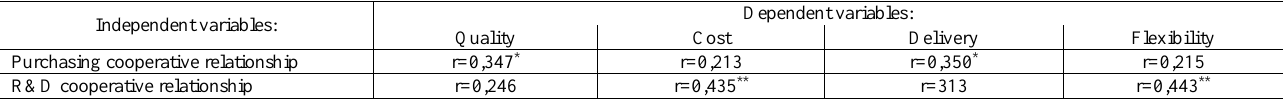
Table 4: Correlation analysis of buyer-supplier relationships with manufacturing performance Independent